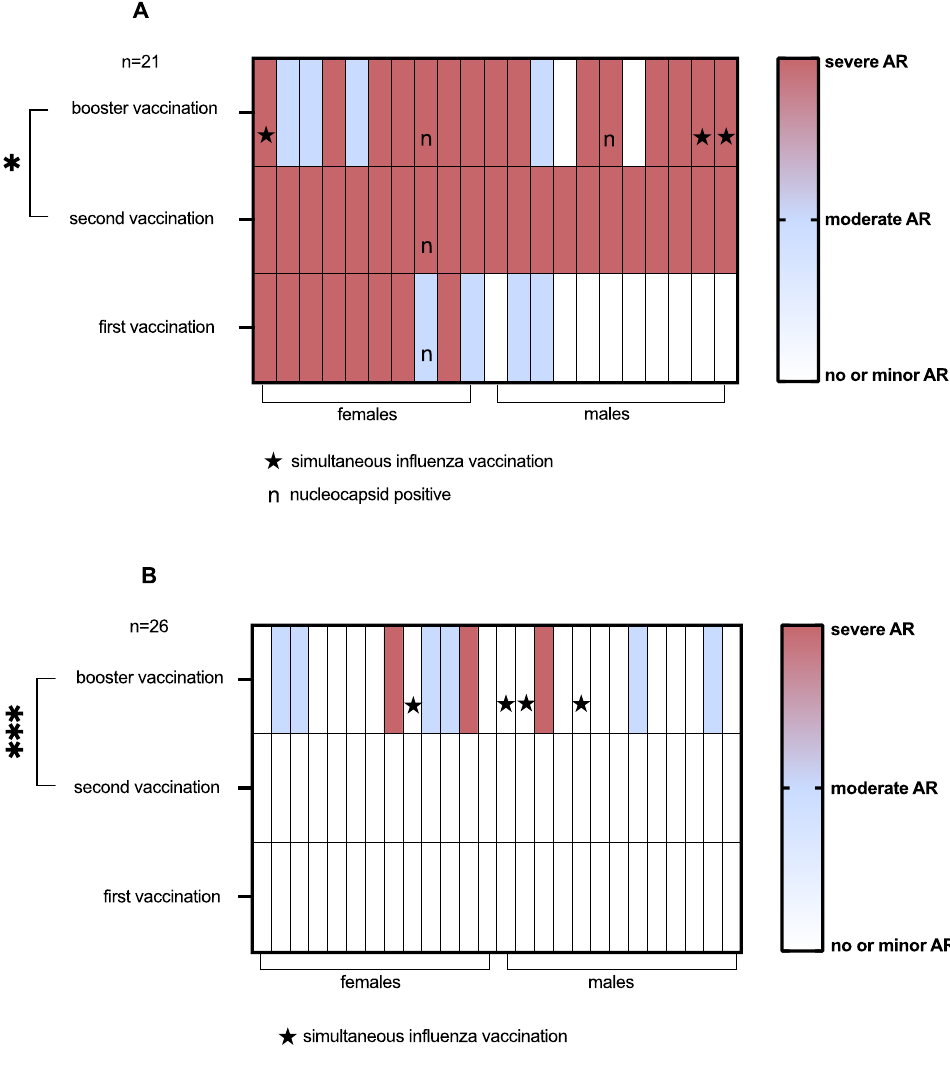
Figure 2. Heat map of reactogenicity profiles. After second vaccination, two groups were formed to compare vaccinees with most severe adverse reactions ( A ) with those who had no or only minor injection site symptoms ( B ). Shown are individual reactogenicity profiles after first, second and booster vaccination with BNT162b2. Subjects who received booster and influenza vaccination simultaneously are marked with asterisks, subjects with positive nucleocapsid measurements are marked with “n”. For statistical analysis, Fleiss–Everitt ordered categories chi2 test was used. AR = adverse reactions. * p < 0.05; *** p < 0.001